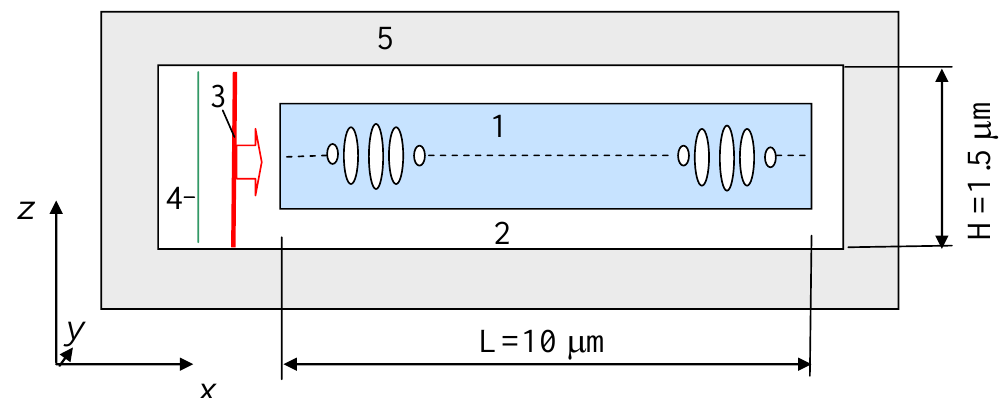
Figure 3. Scheme of the finite time difference domain (FDTD)-simulated domain. 1 — CLC deformed lying helix (DLH)-layer; 2 — the medium with a refractive index of 1.46; 3 — unidirectional light source; 4 — sensor of the reflected light; 5 — the uniaxial perfectly matched layers. The light source (4) generates a pulse of the electromagnetic field propagating along the x-axis.